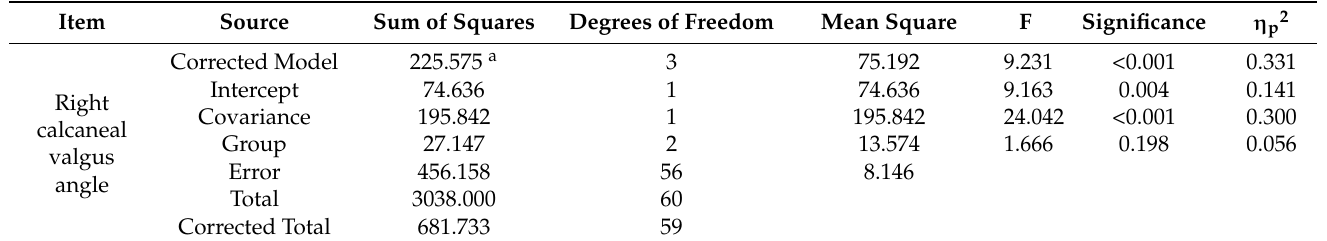
Table 12. Analysis of covariance results concerning right calcaneal valgus